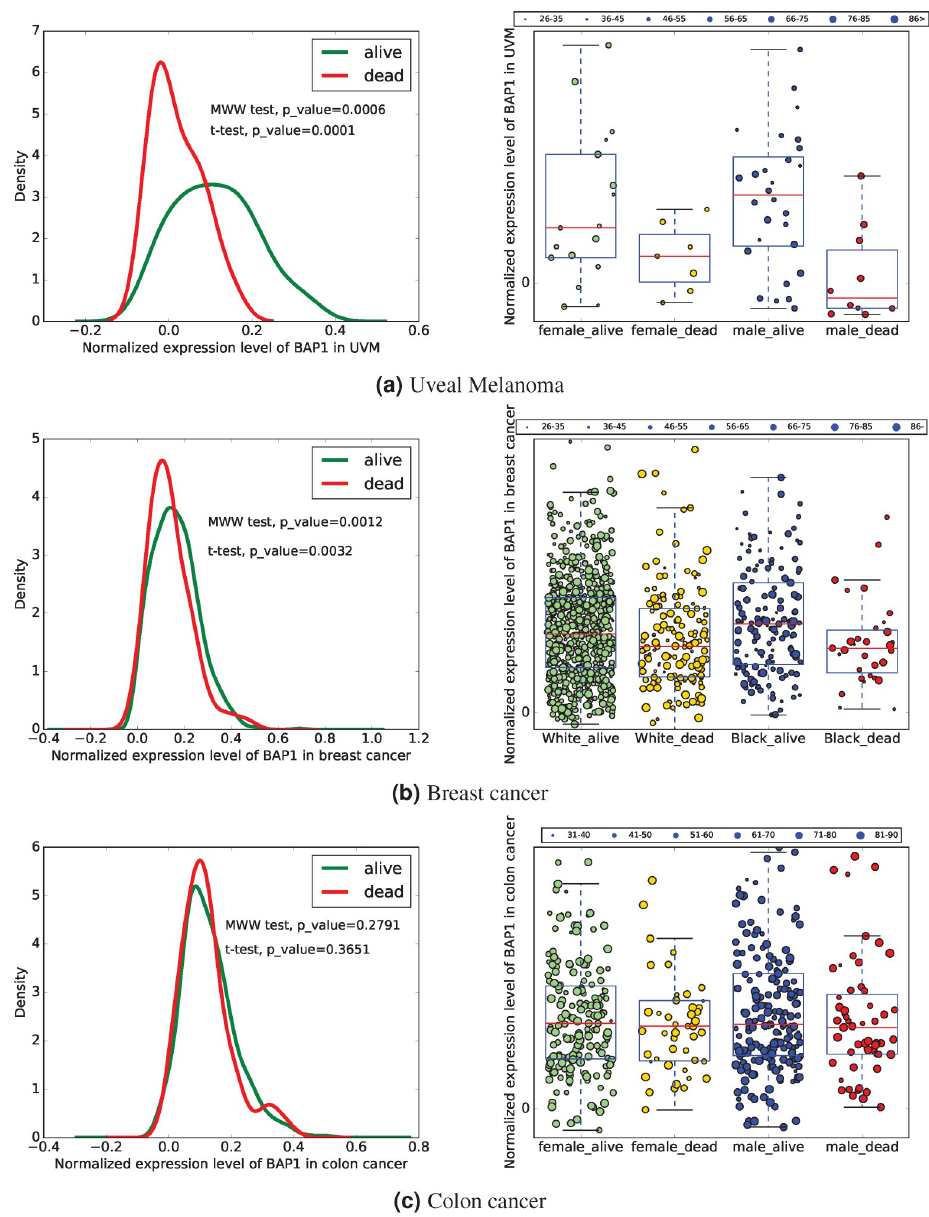
Fig 1. BAP1 expression. The left and right sub-figures respectively represent the density function and the values of BAP1 after normalizing the data set excluding genes with zero values. The size of circles represents the age at